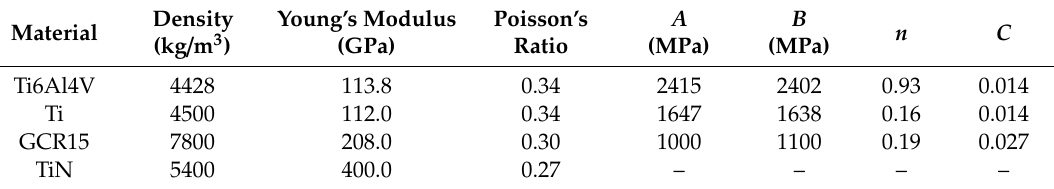
Table 5. Material parameters of the Finite element modelling.